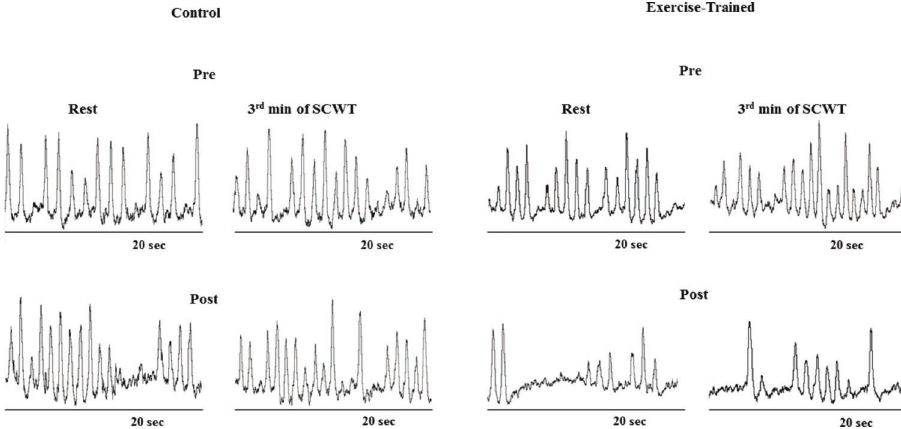
Figure 3 - Sympathetic neurograms (30 sec) at rest and during 3 min of Stroop Color Word Test